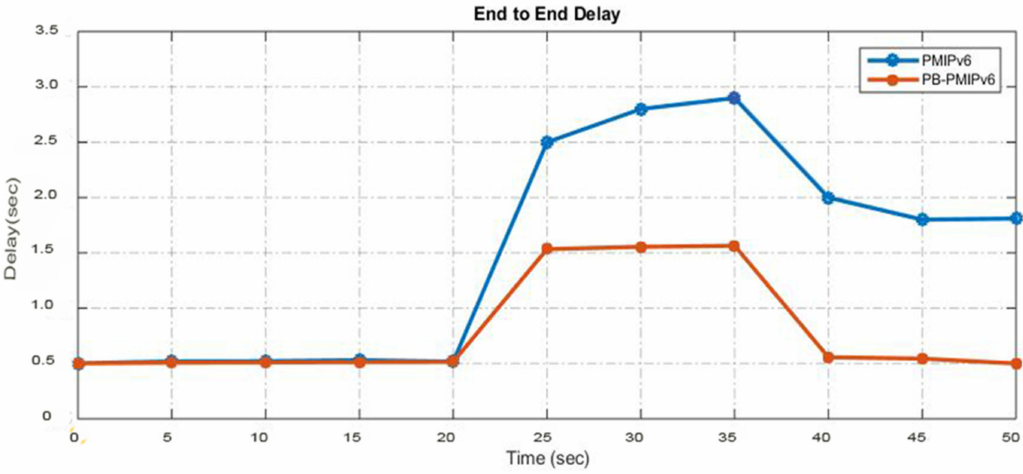
Figure 12. Comparison of end to end